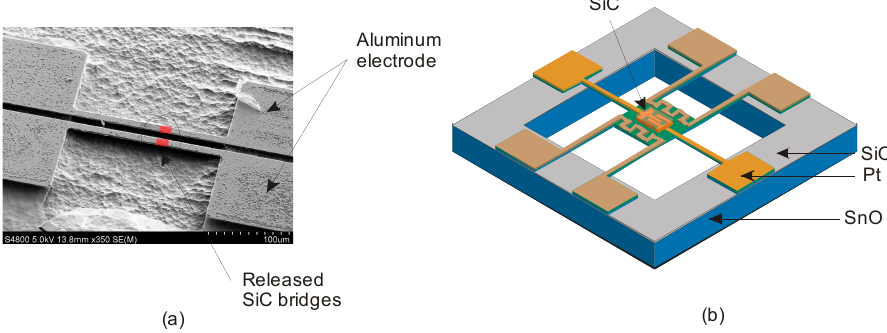
Figure 6. ( a ) Suspended silicon carbide resistor; ( b ) Design of high temperature micro-heater chip based on suspended SiC membrane.